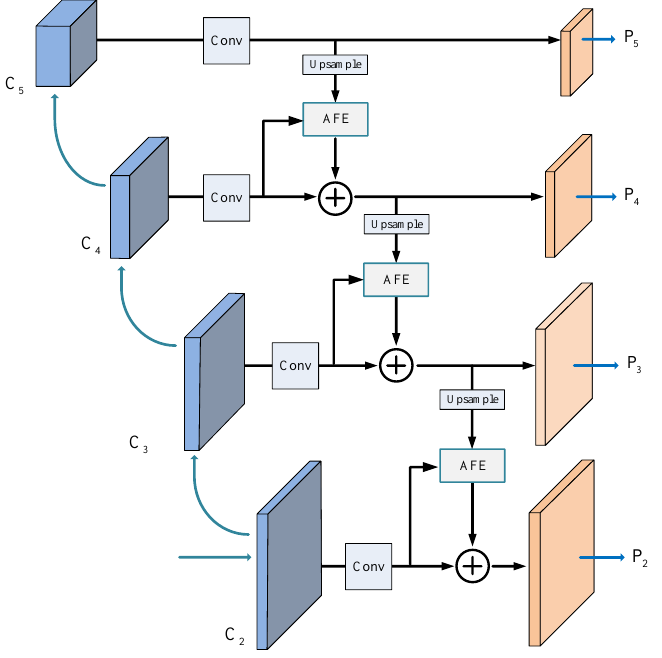
Figure 2. Structure of the adaptive feature pyramid. AFE: adaptive feature